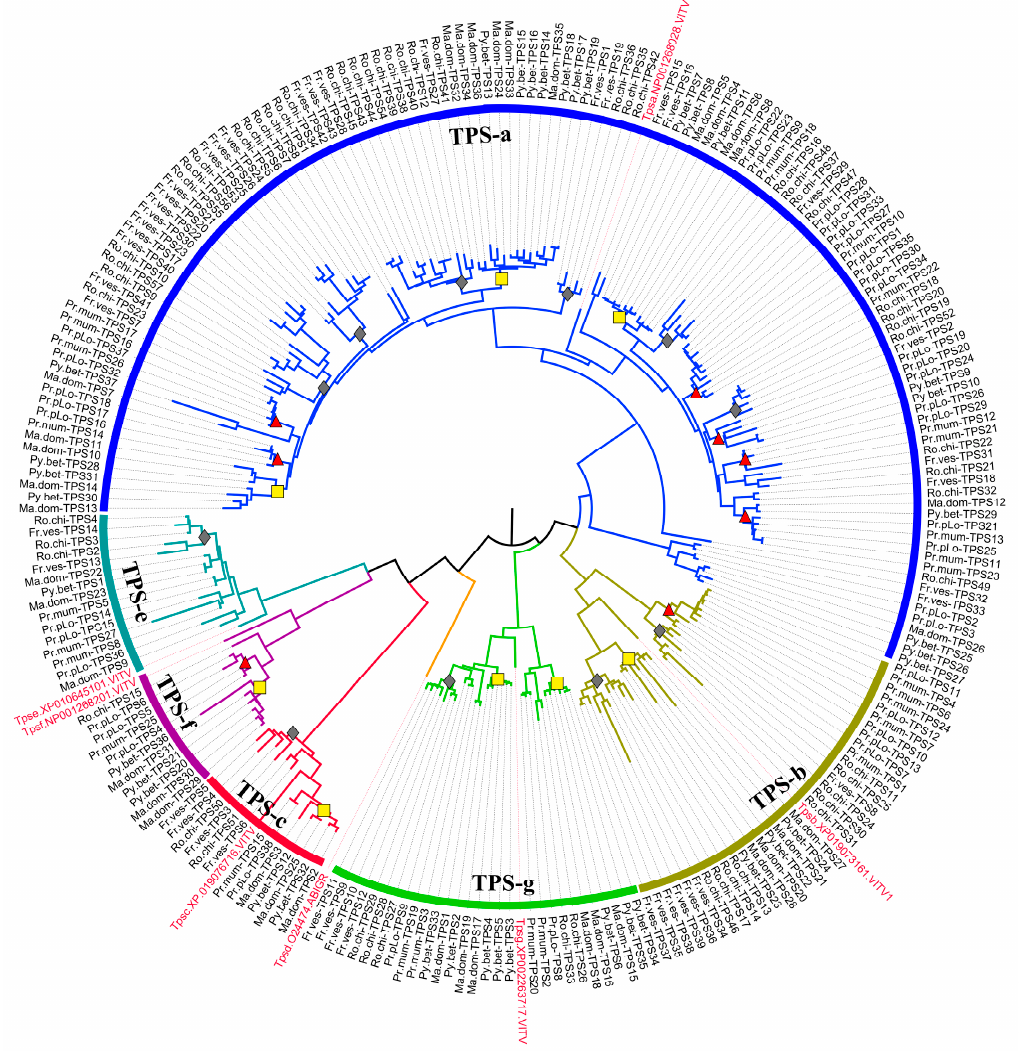
Figure 3. Phylogenetic tree of complete TPSs from six representative Rosaceae species. The TPS members were identified from six species including two Prunoideae species ( P. persica , P. mume ), two Maloideae species ( M. domestica , P. betulifolia ), and two Rosoideae species ( F. vesca , R. chinensis ); only those TPSs containing both PF01397 and PF03936 domains were used. The phylogenetic tree from full-length amino acid sequences was constructed using the MEGA with maximum likelihood (ML) method. Representative sequences of TPSs from Vitis vinifera were used as outgroups. The branches of TPS-a, TPS-g, TPS-b, TPS-c, TPS-e, and TPS-f clades are indicated by blue, green, yellow-green, red, benzo, and purple colors, respectively. The lineage-specific expansion of TPSs in Prunoideae, Maloideae, Rosoideae are indicated by yellow squares, grey diamonds, red triangles, respectively. The enlarged phylogenetic tree with bootstrap values is shown in Supplementary Figure